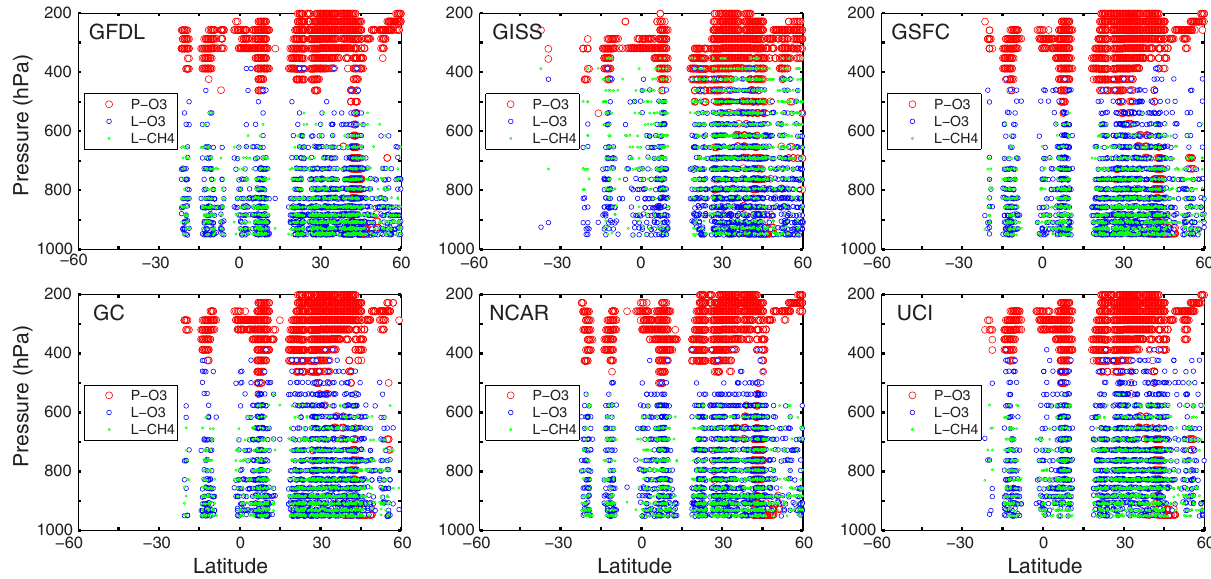
Figure 5. Latitude (degrees) by pressure (hPa) location of the top 10% of reactive parcels for the six models: P -O3 (red, large circles); L -O3 (blue, medium); L -CH4 (green,